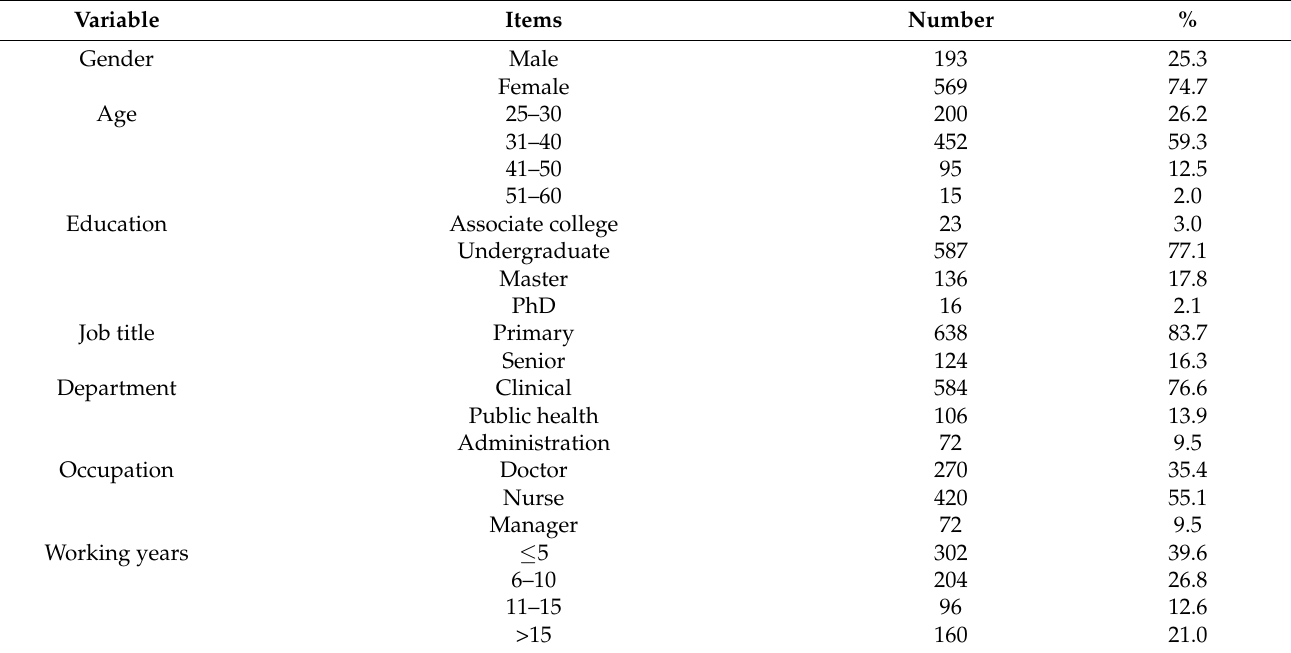
Table 4. Descriptive statistics of the participants (n =